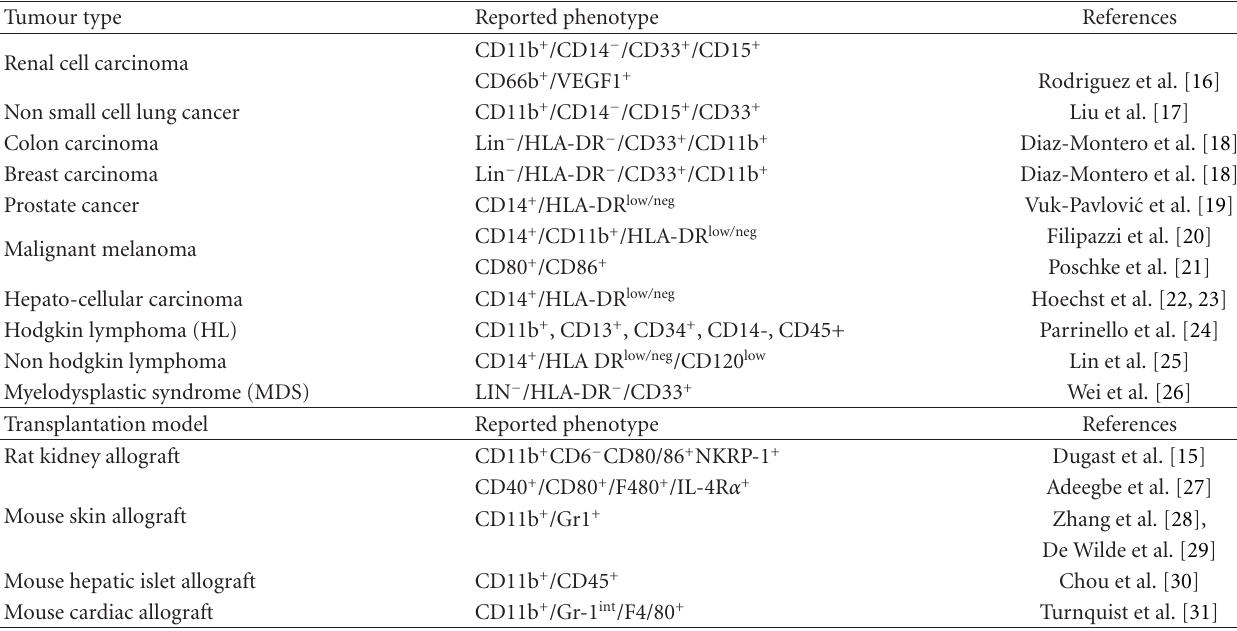
Table 1: Summary of phenotype of MDSCs in tumors and transplantation